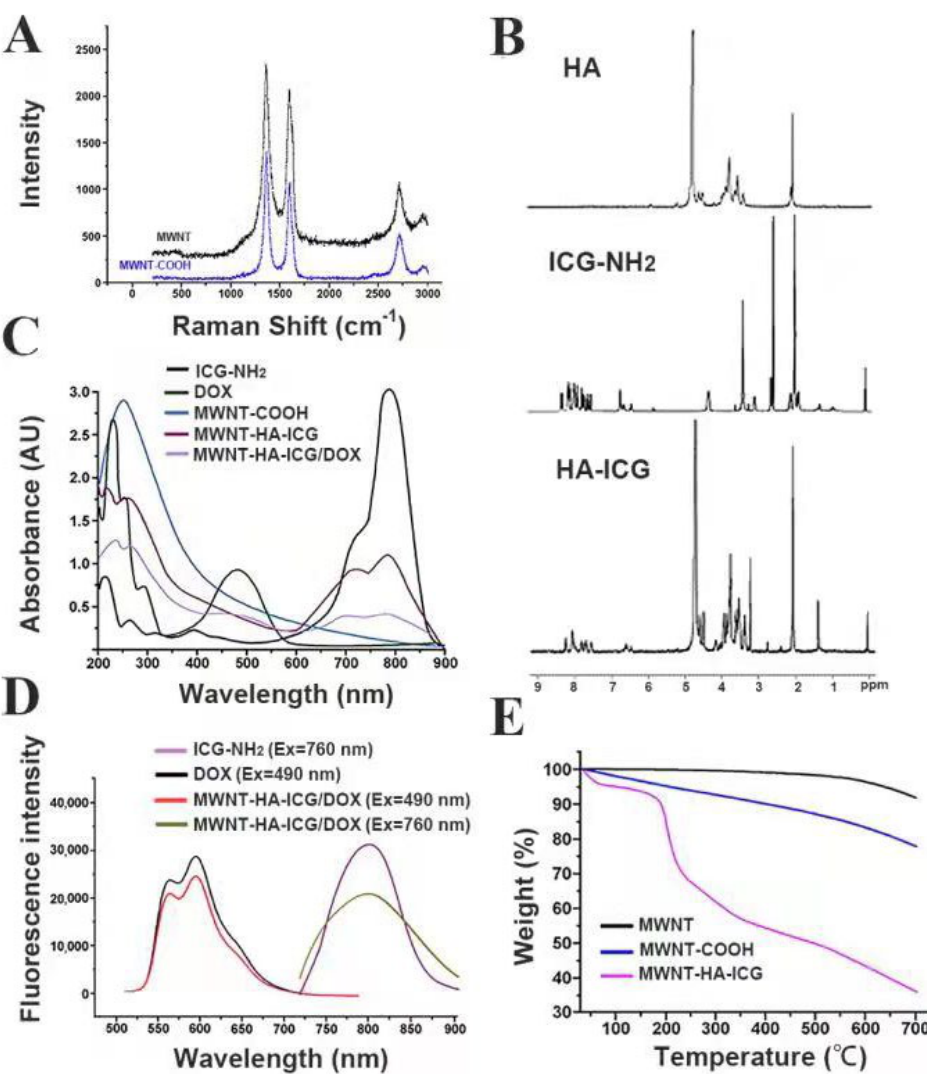
Figure 2. ( A ) Raman spectra of MWNT and MWNT-COOH. ( B ) 1 H-NMR spectra of HA, ICG-NH 2 , and HA-ICG. ( C ) UV spectra of ICG-NH 2 , DOX, MWNT-COOH, MWNT-HA-ICG, and MWNT-HA-ICG/DOX. ( D ) Fluorescence spectra of ICG-NH 2 , DOX, and MWNT-HA-ICG/DOX. ( E ) TGA curves of MWNT, MWNT-COOH, and MWNT-HA-ICG.